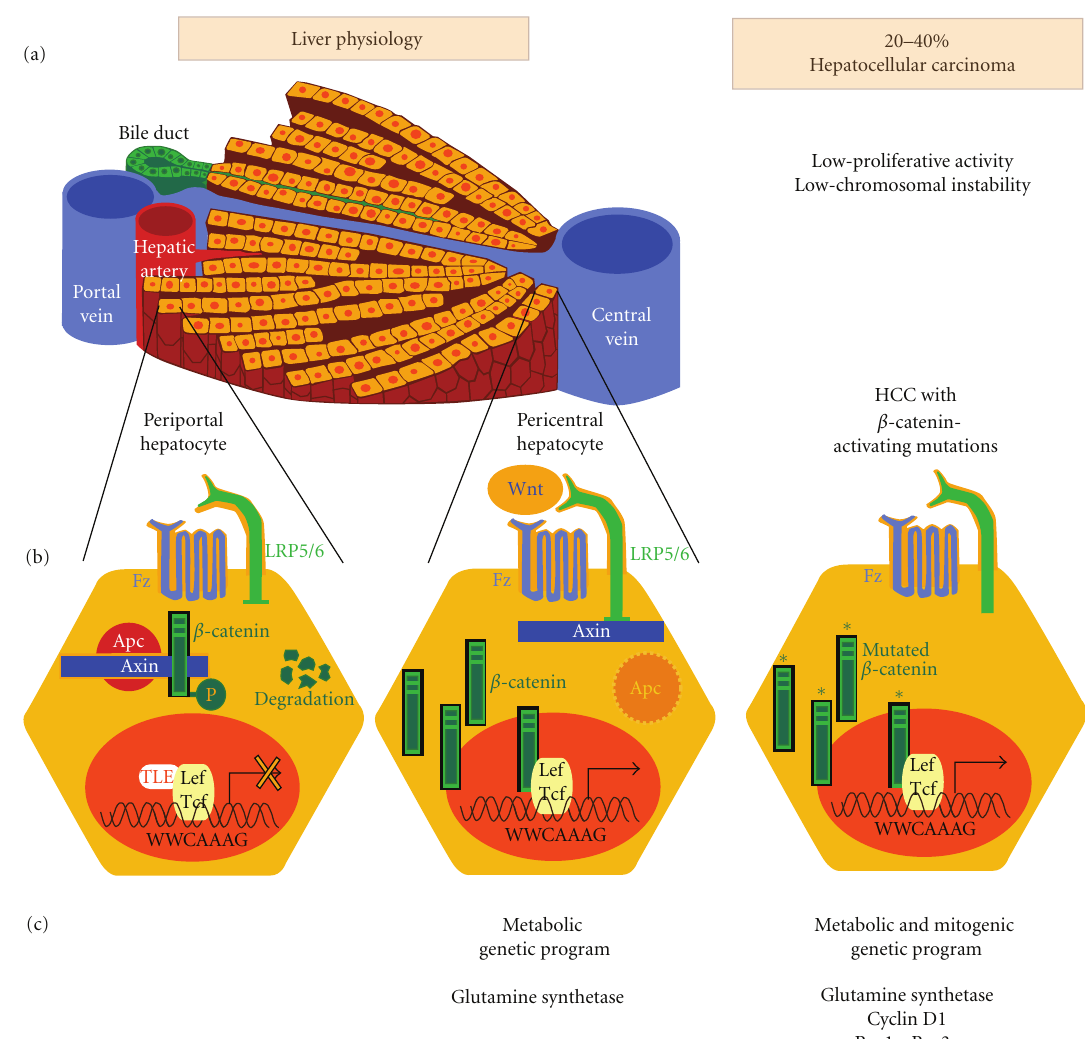
Figure 1: Wnt signalling in the adult quiescent liver and in CTNNB1-mutated HCCs. (a) The liver-cell plate and its portocentral organization; (b) the periportal hepatocyte is deprived of Wnt signalling, due to its high amount of Apc, allowing the destruction complex to be e ffi cient to degrade β -catenin. The pericentral hepatocyte has a Wnt-dependent β -catenin signalling, while in HCCs it is constitutively activated due to mutations in phosphorylation residues in CTNNB1; (c) the output of the transcriptional β -catenin is metabolic in the pericentral hepatocyte, while it is both metabolic and mitogenic in